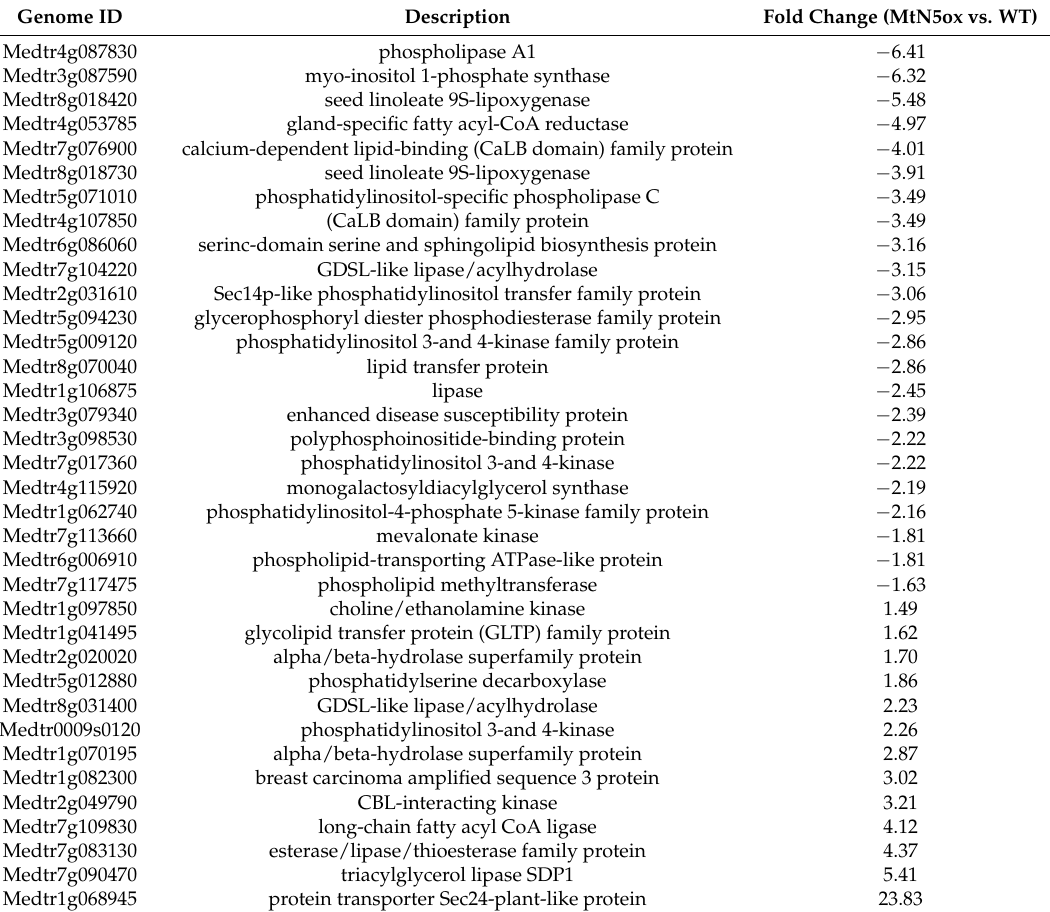
Table 3. DEGs involved in lipid